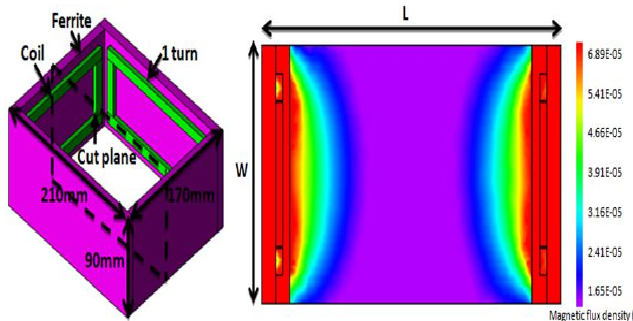
Figure 6: Horizontal field FEM Model (left) and MFD dis- tribution